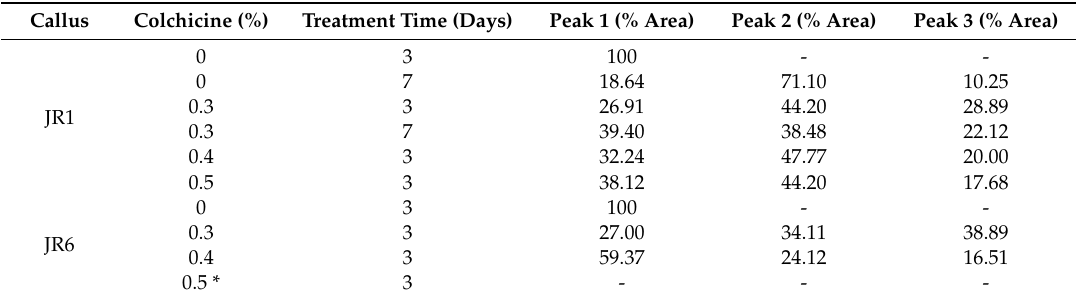
Table 3. Ploidy level of callus treated with colchicine.